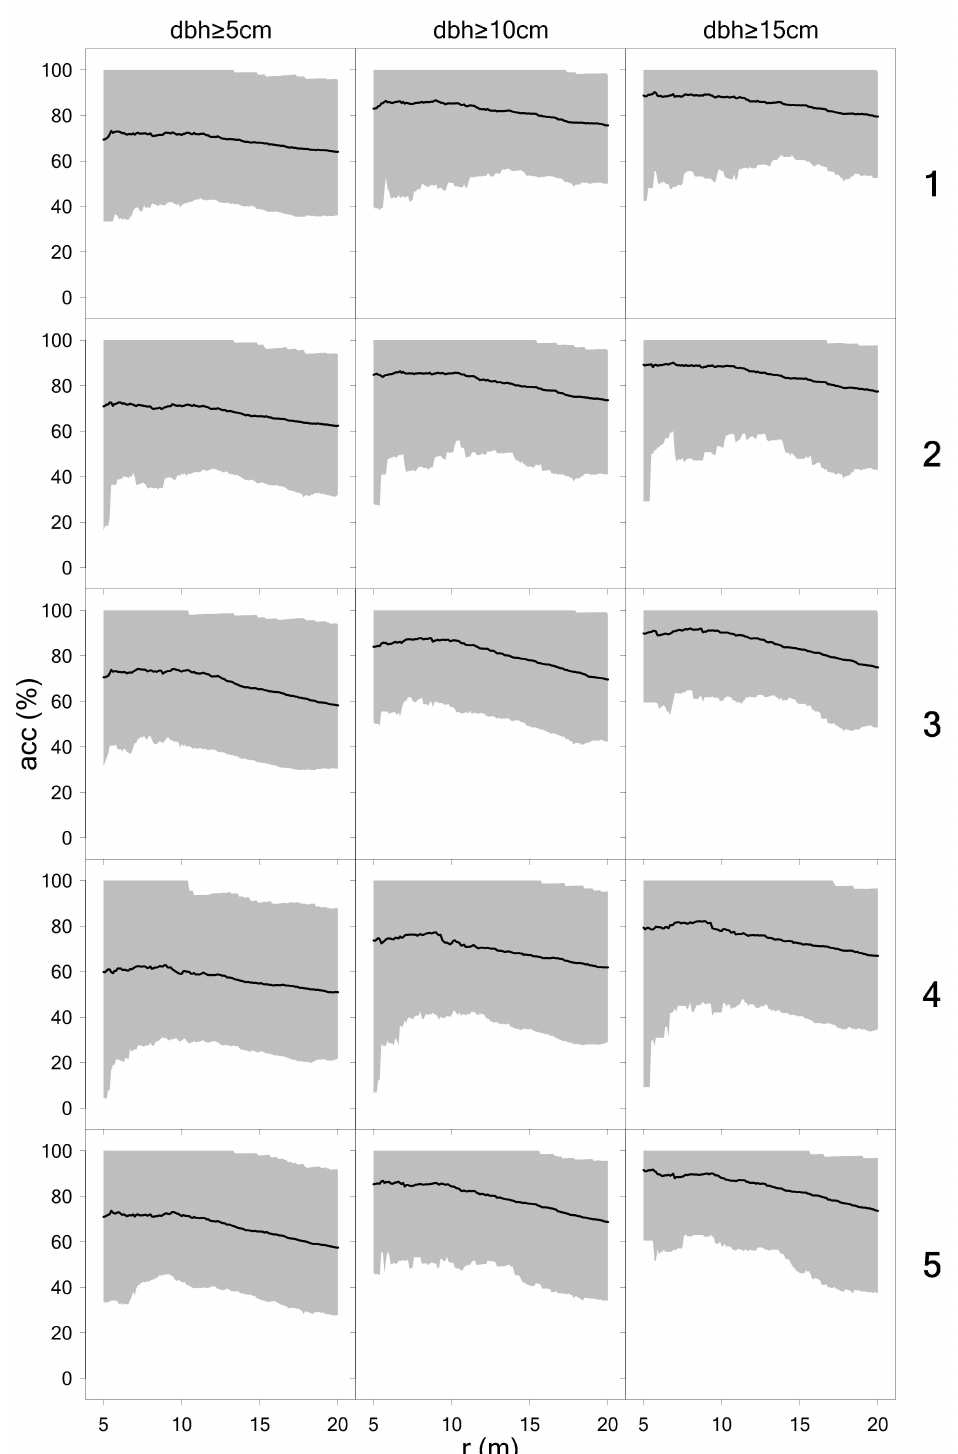
Figure A5. Overall accuracy over plot radius. Bold black line indicates mean. Gray area indicates 95% confidence envelope. Bold numbers on the right mark scan